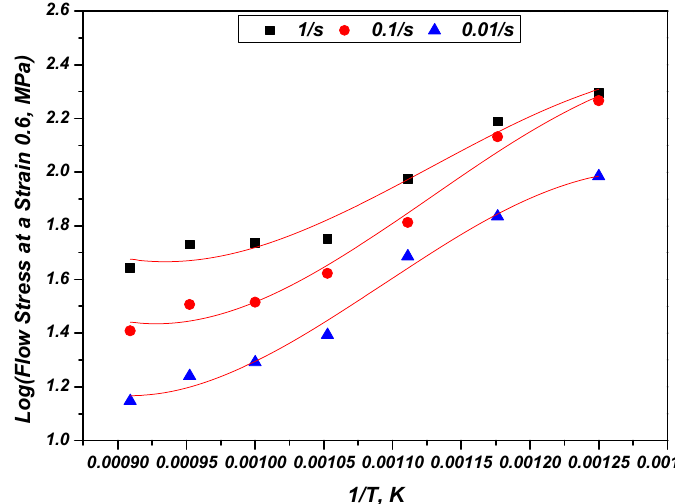
Figure 8. Deformation contour map shown by temperature ‐ log(strain rate) relation of Ti ‐ 6Al ‐ 4V alloy ( ε = 0.6) by Ziegler’s instability criterion ( ξ ).